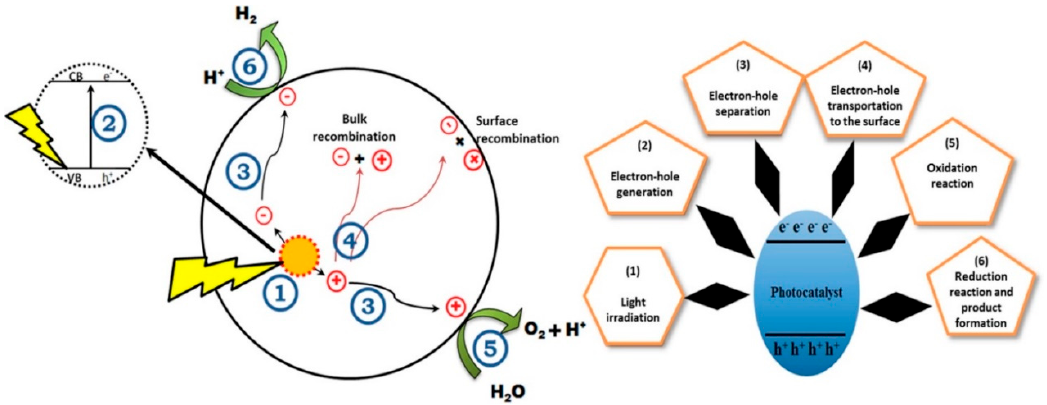
Figure 5. Photocatalytic hydrogen production mechanism. Reprinted with permission from [111].